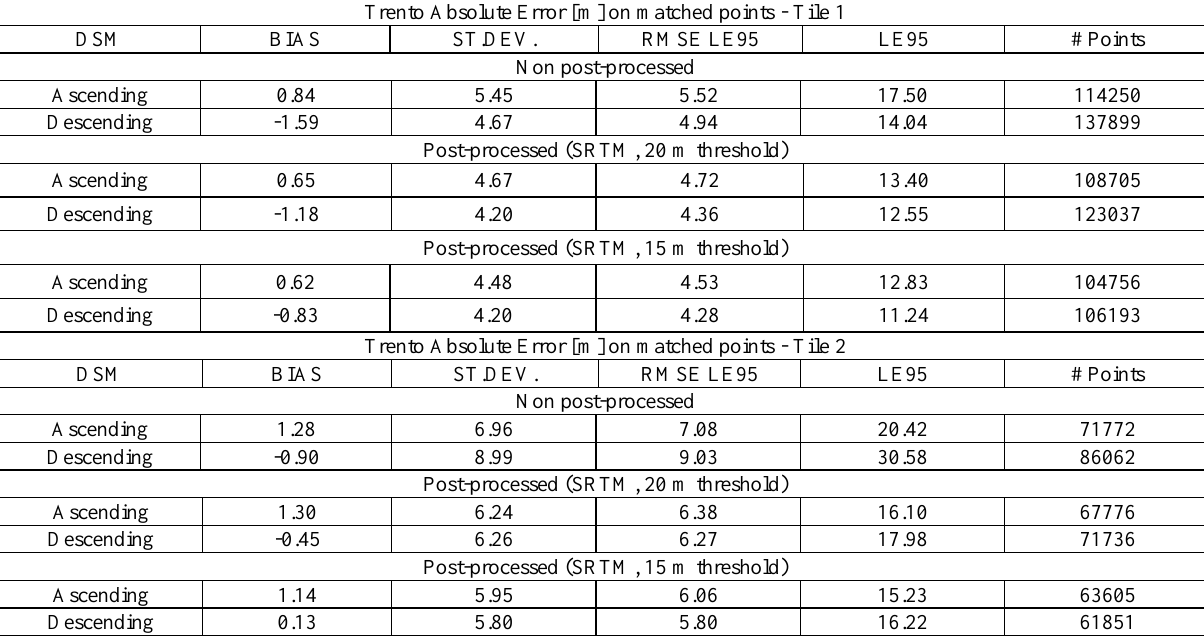
Table 2. Trento matched points analysis results